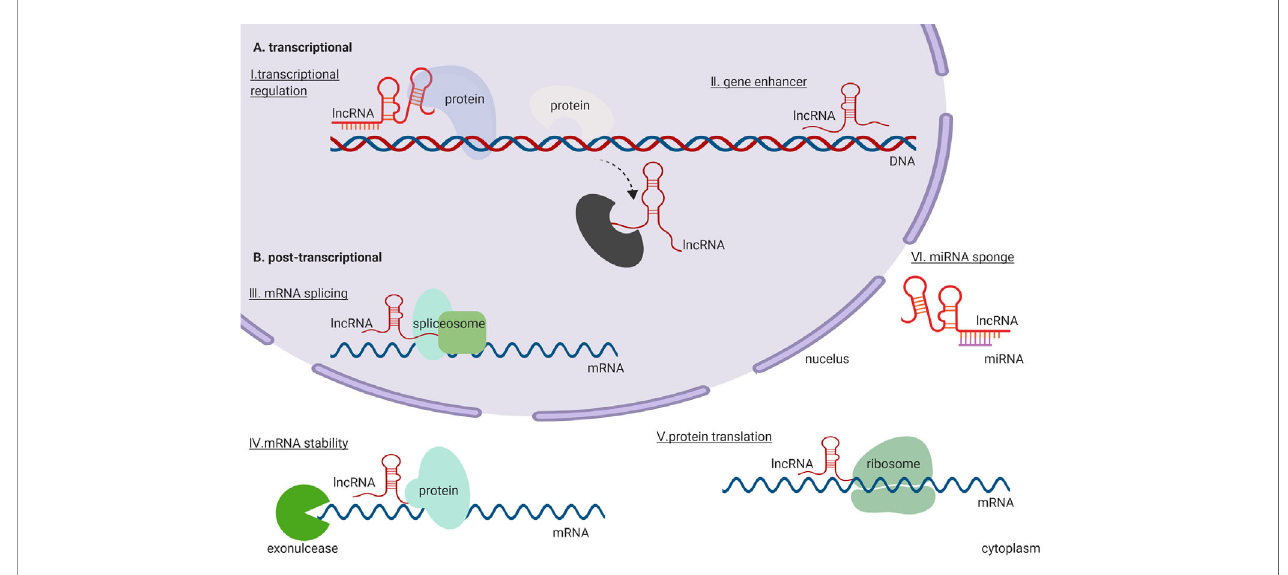
FIGURE 1 | General functions and regulatory mechanisms of lncRNAs in the cell. (A) lncRNAs exert their functions in the transcriptional regulation. (B) lncRNAs exert their functions in the post-transcriptional